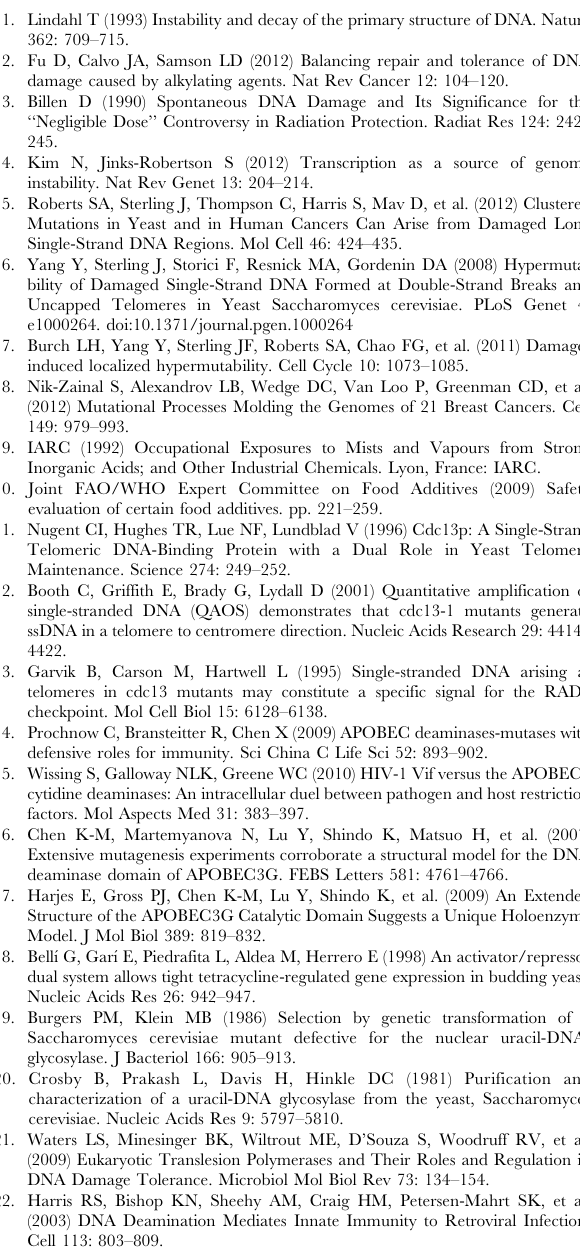
Table S3 Catalog of mutations induced by APOBEC3G in subtelomeric ssDNA. Table S4 Catalog of mutations induced by bisulfite in subtelomeric ssDNA. Table S5 Catalog of mutations found in CAN1 among temperature-shifted cdc13-1 cells bearing pCM252 with no insert. Table S6 Catalog of mutations found in CAN1 among temperature-shifted cdc13-1 cells treated with 100 mM citrate buffer, pH